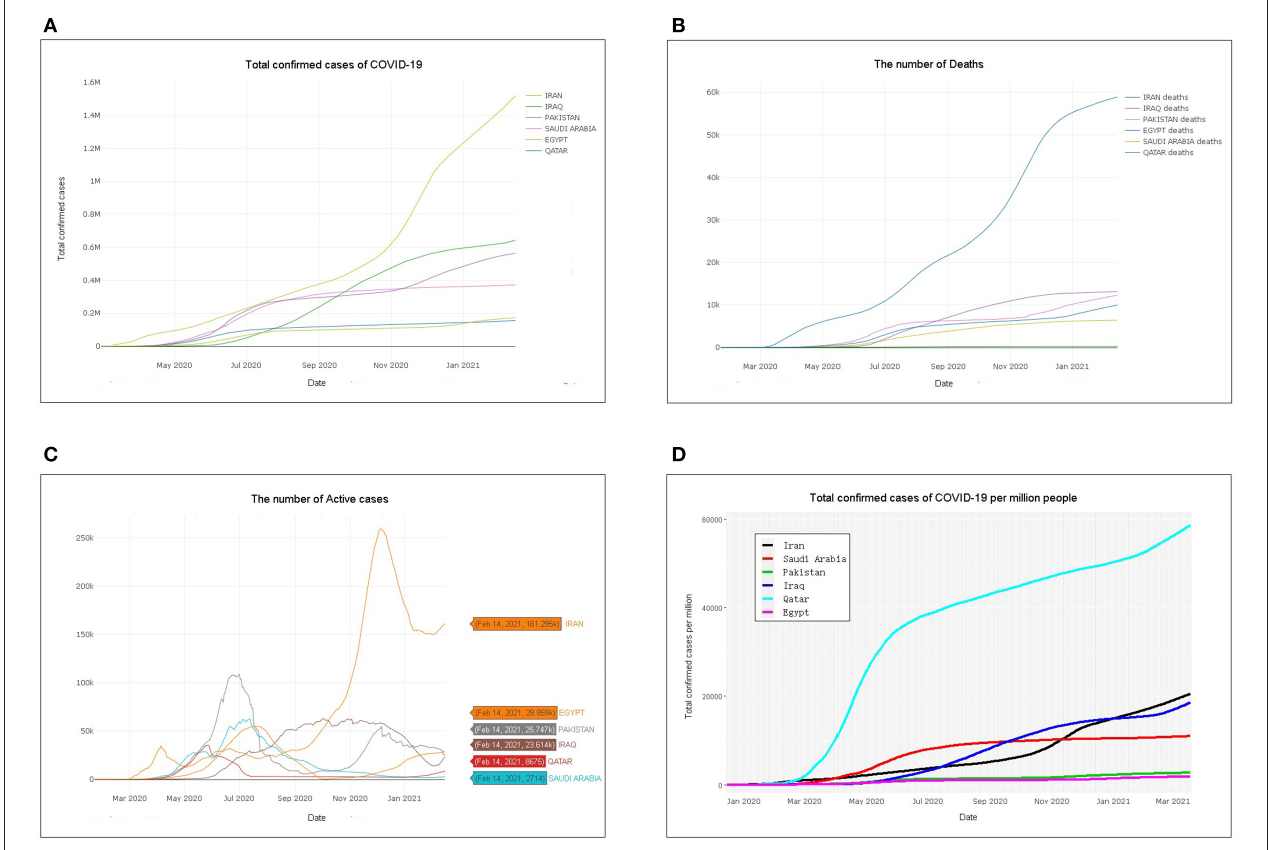
FIGURE 1 | Total confirmed cases, deaths, active cases, and total confirmed cases per million people: (A ) number of total confirmed coronavirus disease 2019 (COVID-19) cases, (B) number of deaths in six Eastern Mediterranean countries, (C) number of active cases in six Eastern Mediterranean countries, and (D) total confirmed cases per million